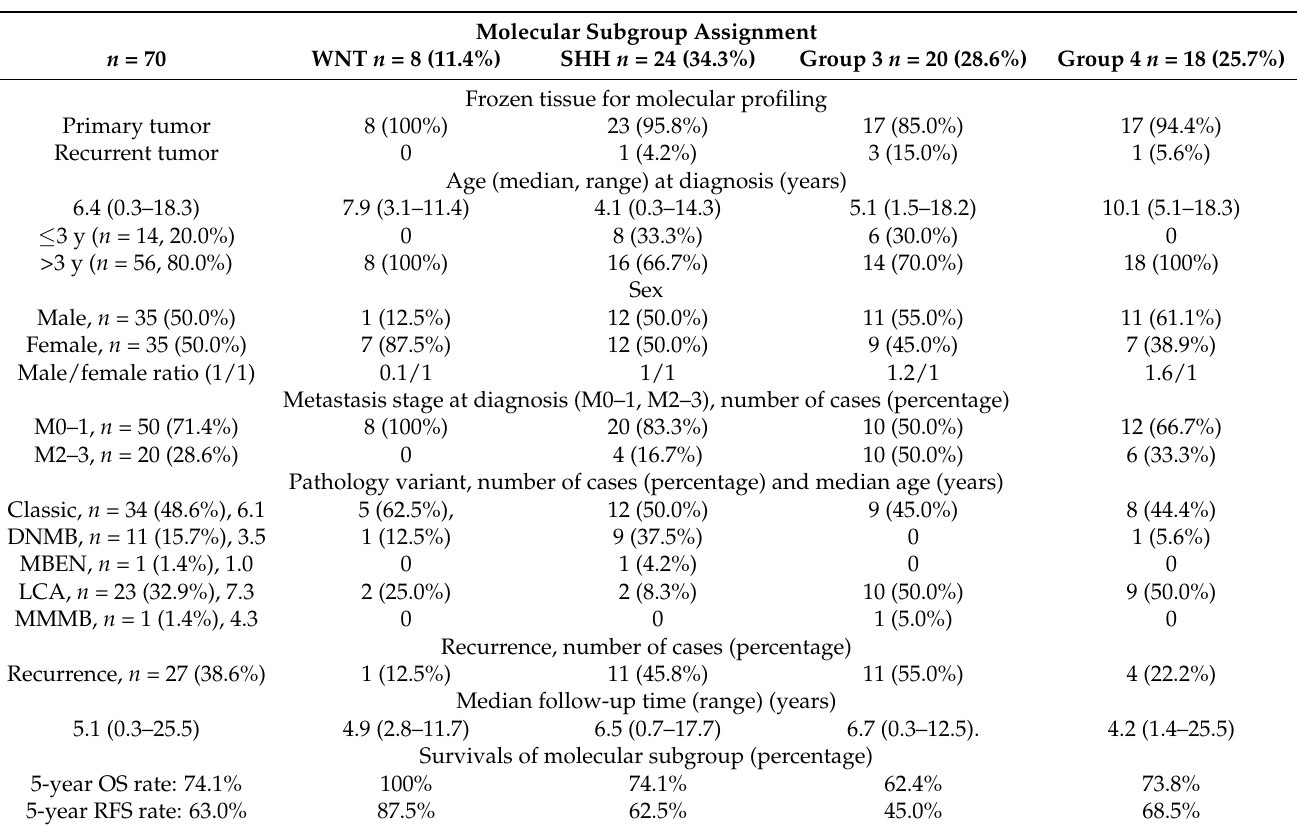
Table 1. Demography, molecular subgroup, clinical data, and molecular–clinical correlation in our cohort of 70 childhood medulloblastomas (MBs) in